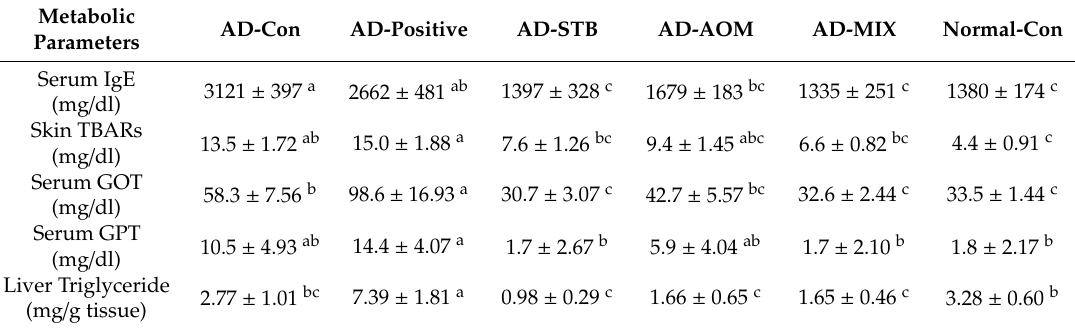
Table 2. Index of atopic dermatitis-related parameters and liver